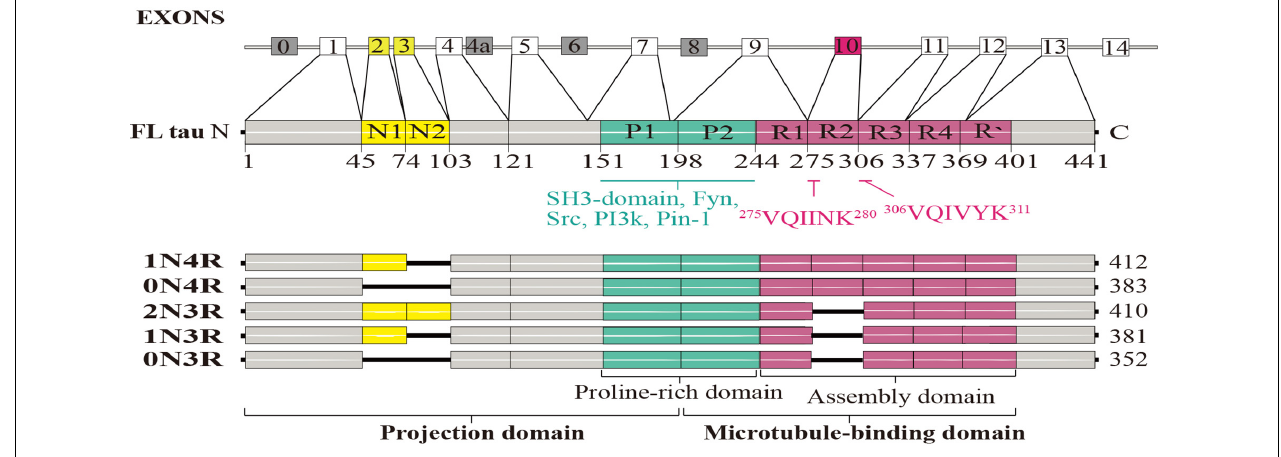
FIGURE 1 | Structural features of the tau protein. The human tau gene, microtubule-associated protein tau (MAPT), contains 16 exons; alternative splicing of exons 2, 3, and 10 generates six tau protein isoforms: oN3R, 1N4R, 2N3R, 0N4R, 1N4R, and 2N4R. Full-length human tau protein (2N4R) contains 441 amino acids and four functional domains: an N-terminal projection region, a proline-rich domain, a microtubule-binding domain (MBD), and a C-terminal region. The N-terminal inserts are N1 and N2. The proline-rich domains P1 and P2 contain many phosphorylation sites and can bind to SH3 domains of other proteins, such as the tyrosine kinase Fyn. R1-R4 make up the repeat domain, which, together with the R’-flanking region, constitute the MT-binding domain. Two sequences are necessary for tau aggregation: 275 VQIINK 280 and 306 VQIVYK 311